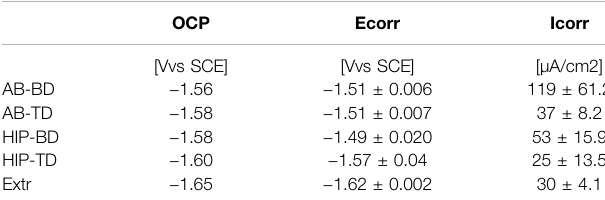
TABLE2| OCP,corrosion potential,and